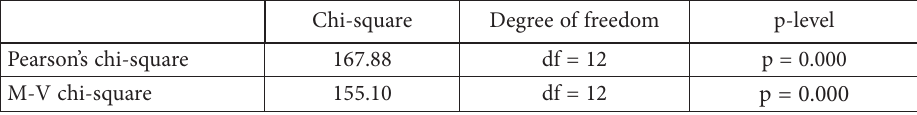
Table 13. χ 2 test for motivational factor job security from the point of view of education Chi-square Degree of freedom p-level Pearson’s chi-square 167.88 df = 12 p = 0.000 M-V chi-square 155.10 p = 0.000